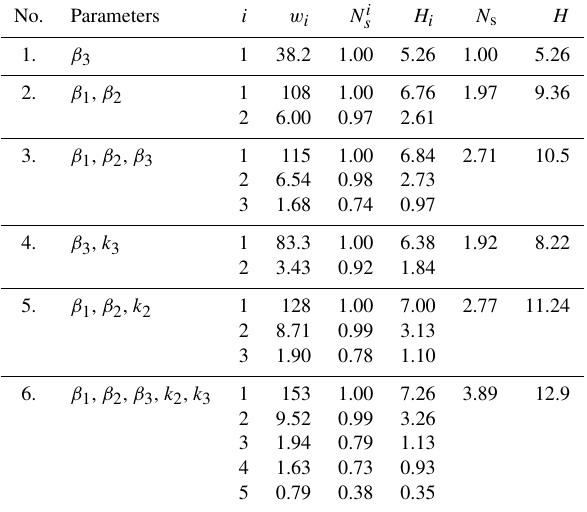
Table 3. Signal degrees of freedom N s and change in entropy H for the lowest model layer (closest to the surface). Also shown are the singular values w i and their contributions N i s and H i to N s and H , respectively. The results have been obtained by assuming an obser- vation standard deviation of 50%.